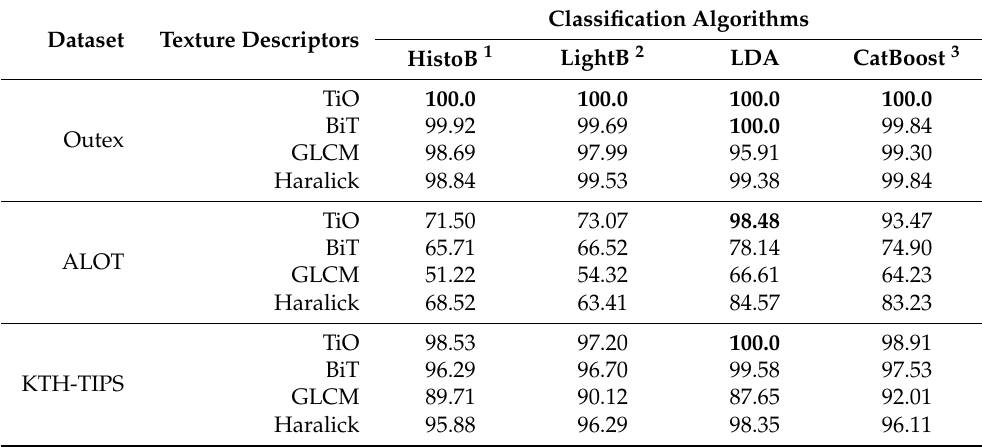
Table 1. Average accuracy (%) on the test set of the Outex, ALOT, and KTH-TIPS datasets. The best accuracy for each dataset is shown in boldface.